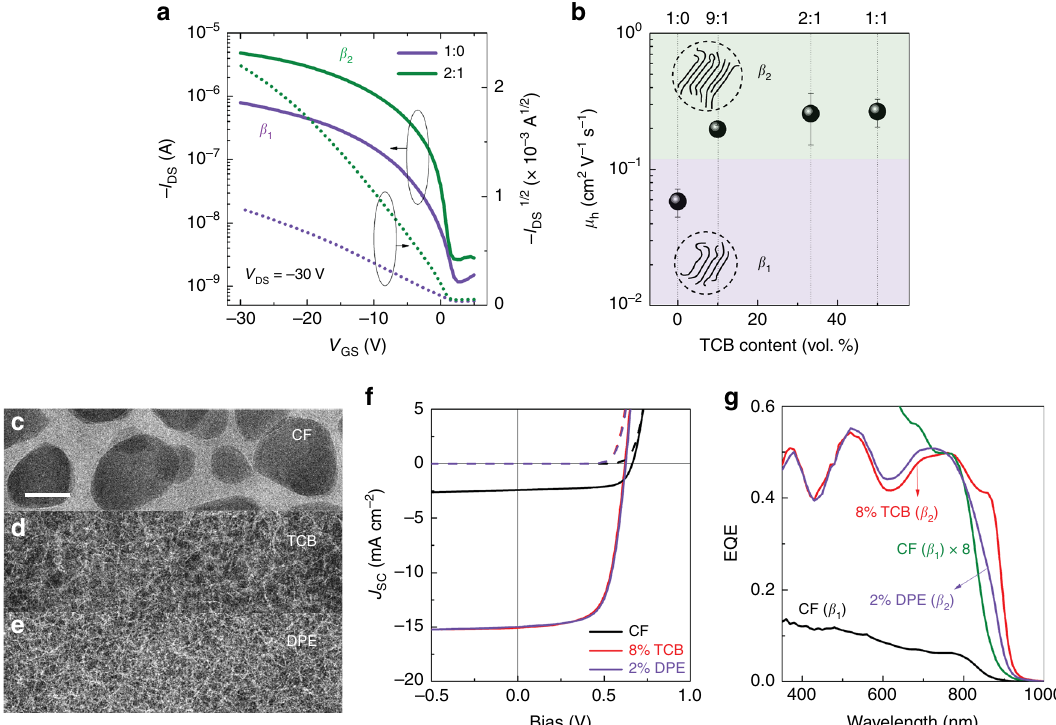
Fig. 7 Field-effect transistors and solar cells of the two polymorphs. a Transfer characteristics of D-PDPP4T-HD fi eld-effect transistors for the β 1 and β 2 polymorphs processed from chloroform:1,2,4-trichlorobenzene (CF:TCB) solutions (1:0) and (2:1). b Average (6 devices) fi eld-effect mobility as a function of TCB content. Error bars are standard deviation. c , d , e TEM images of D-PDPP4T-HD:[70]PCBM blends with various cosolvents. All images share the same scale bar of 200 nm. f J-V characteristics of D-PDPP4T-HD:[70]PCBM solar cells under simulated AM1.5 G (100 mWcm − 2 ) illumination (solid lines). The dash lines indicate the dark current. g Corresponding EQE